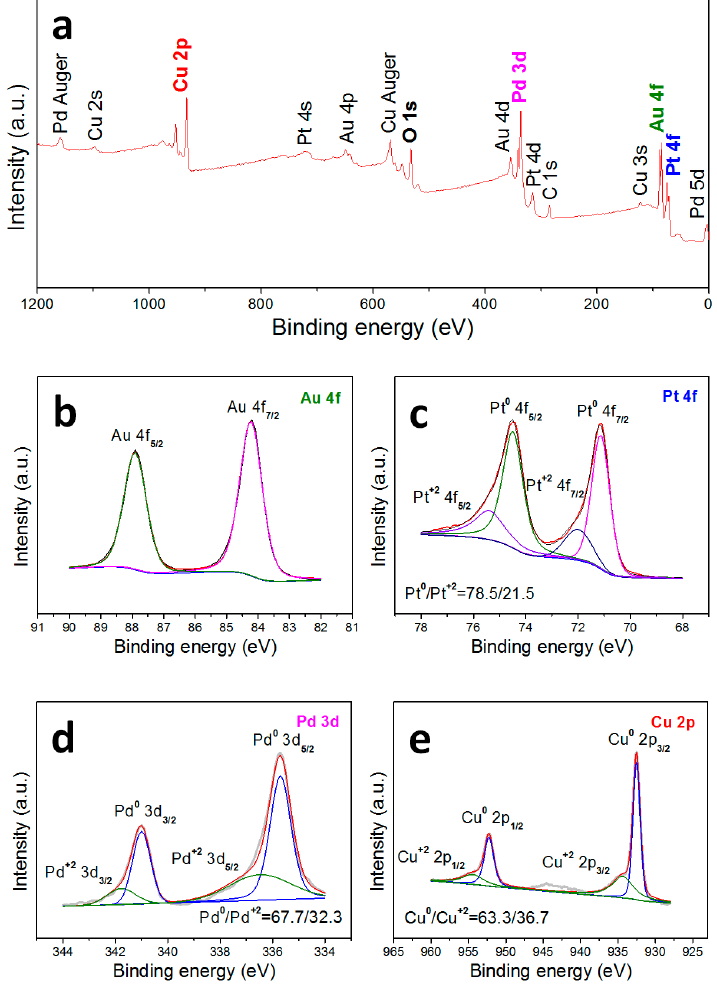
Figure 3. XPS spectra of the precursor microspheres after dealloying in 2M HNO 3 for 24 h: ( a ) fully scanned spectra; ( b ) Au 4f; ( c ) Pt 4f; ( d ) Pd 3d; ( e ) Cu 2p.